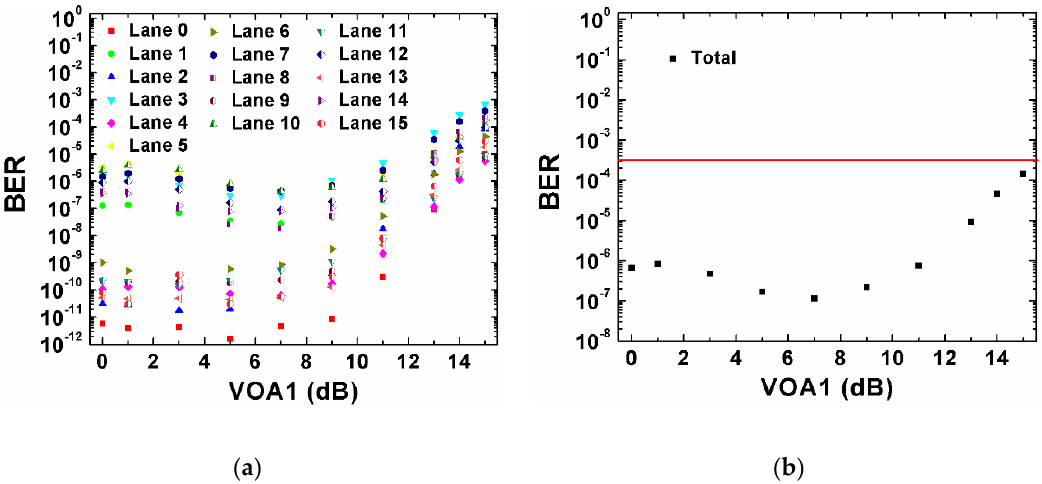
Figure 9. Back-to-back performance for interoperation of two CFP8-LR8 modules. The signal is transmitted from the transmitter (Tx) of the first module to the receiver (Rx) of the second module: ( a ) Bit error rate (BER) vs. VOA1’s attenuation for 16 individual electrical lanes; ( b ) total BER vs. VOA1’s attenuation. The threshold for the uncorrected code word (UCW) is shown as the red line.